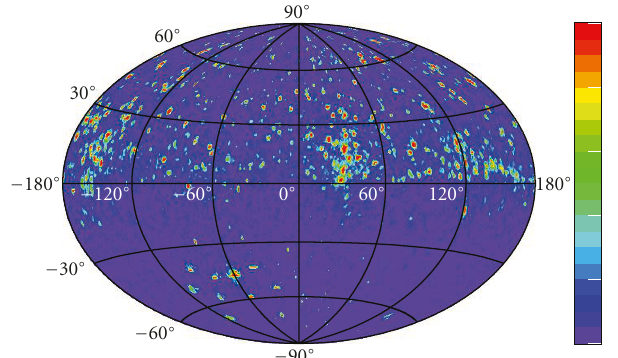
Figure 11: A qualitative mapping of the arrival directions of transient acoustic signals. The majority of the signals come from above. In the lower hemisphere the ANTARES acoustic position system can be